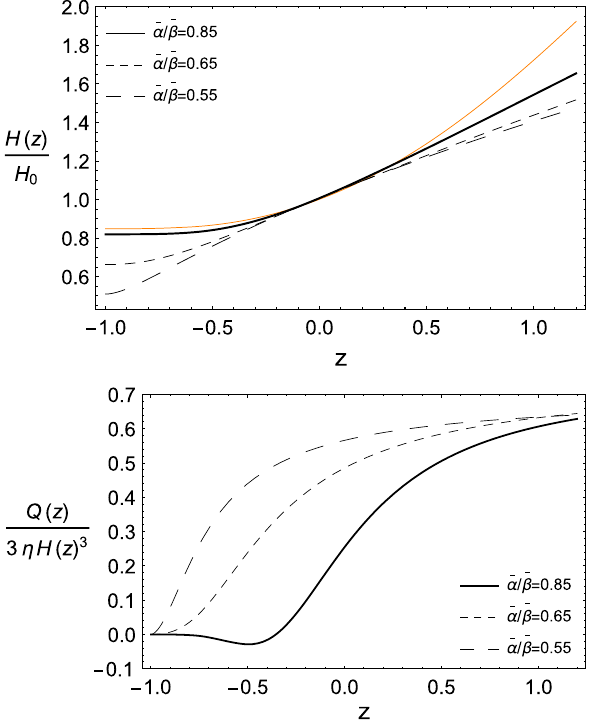
Fig. 2 For the deformed GB DE model it is shown the evolution of the Hubble parameter H ( z ) (upper graph) and the coupling Q ( z ) (lower graph) as functions of the redshift z for the fixed values w = − 1 , η ∼ 1, q ( 0 ) = − 0 . 55 and several different values of the quotient ¯ α/ ¯ β . The orange line corresponds to the evolution of the Λ CDM